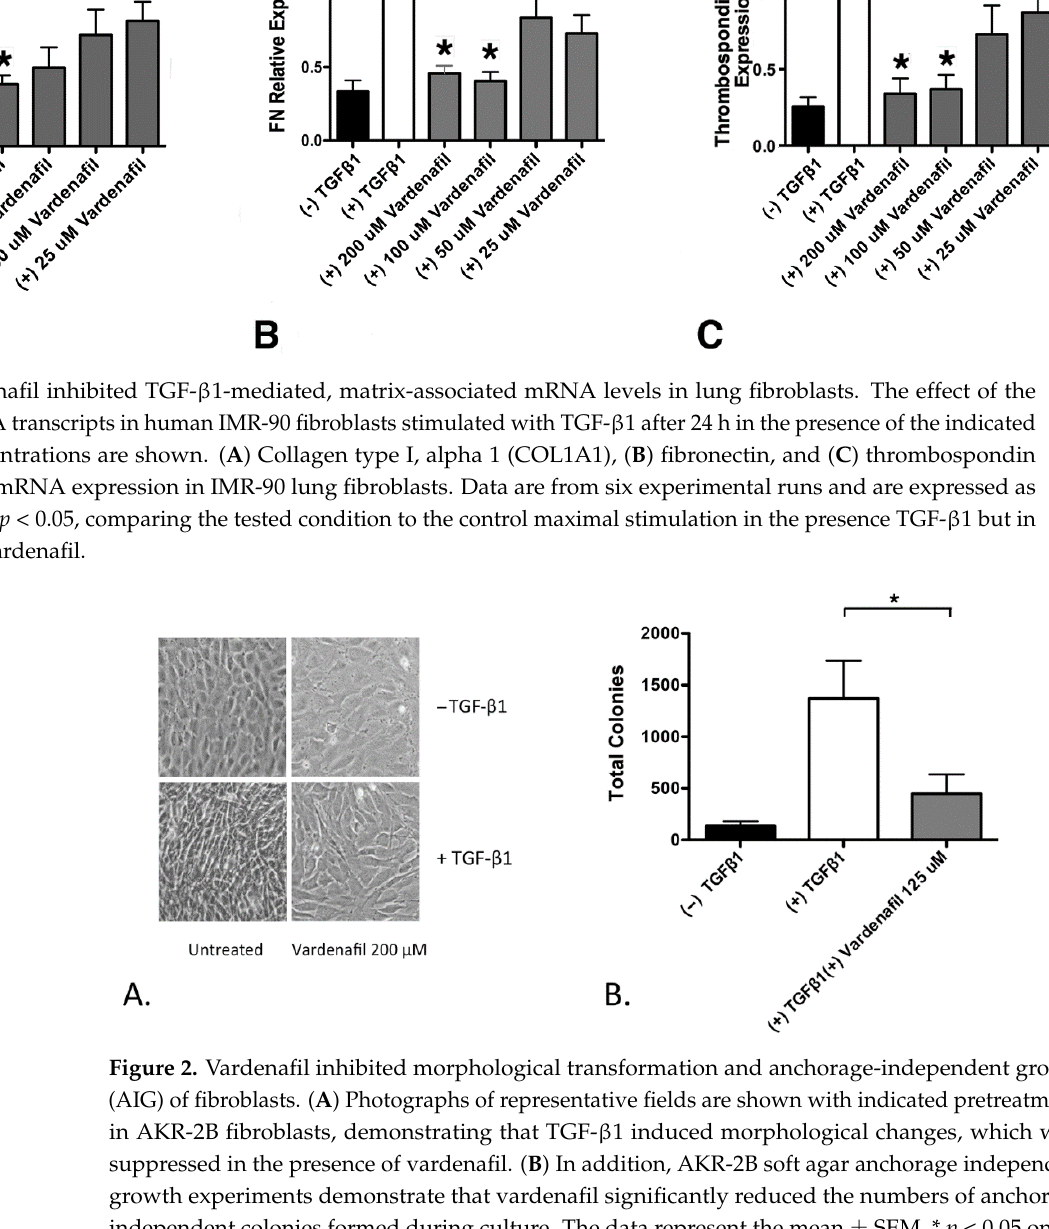
(TSP-1) relative mRNA expression in IMR-90 lung fibroblasts. Data are from six experimental runs and are expressed as means ± SEM. * p < 0.05, comparing the tested condition to the control maximal stimulation in the presence TGF- β1 but in the absence of vardenafil.